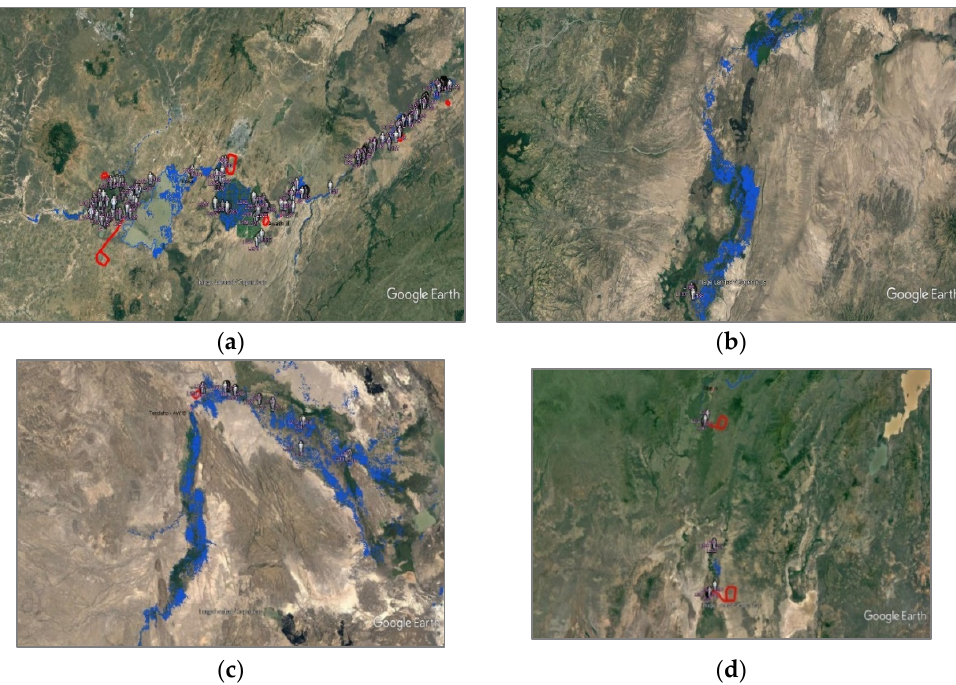
Figure 11. Routes of evacuation in the flood-prone areas. These evacuation routes are ( a ) 5 locations in the upper Awash sub-basin, ( b ) 2 locations in the middle Awash sub-basin, ( c ) 2 locations in the lower Awash sub-basin, and ( d ) 2 locations in the lower Omo-Gibe sub-basin.